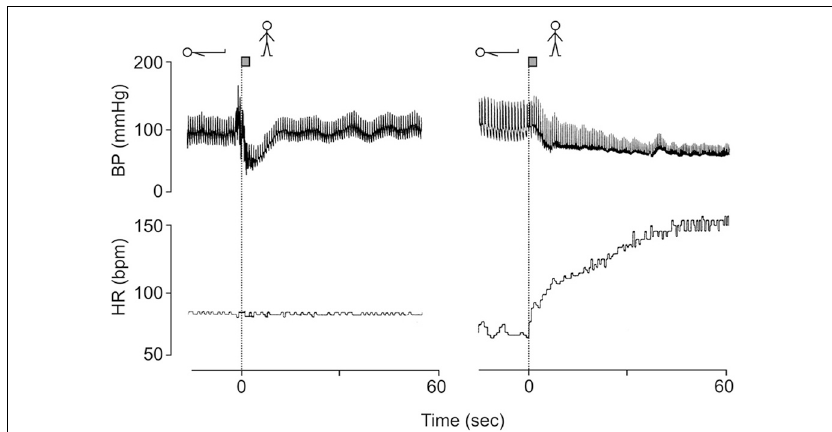
FIGURE 1 | Blood pressure and heart rate responses induced by active standing in a 38 year-old fit patient with a cardiac transplant (left panel) and a 23-year-old female patient with orthostatic hypotension (hypoadrenergic) with intact heart rate control (right panel). Revised after Wieling and Karemaker (2013) with permission of Oxford University press.